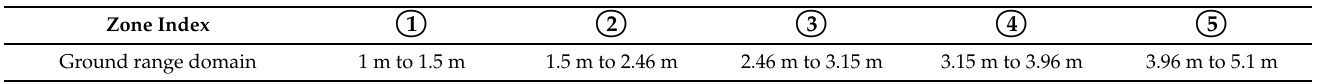
Table 2. Ground range domains corresponding to the regions indicated in Figure